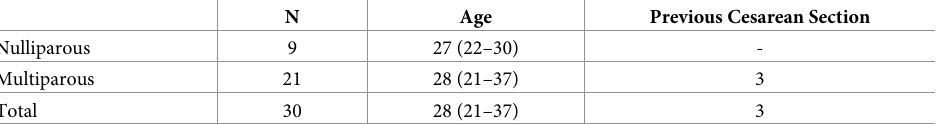
Table 1. Patient demographics including the number of subjects, N, in each group and their average age (age range in parentheses). There were no patients with a BMI larger than 30.